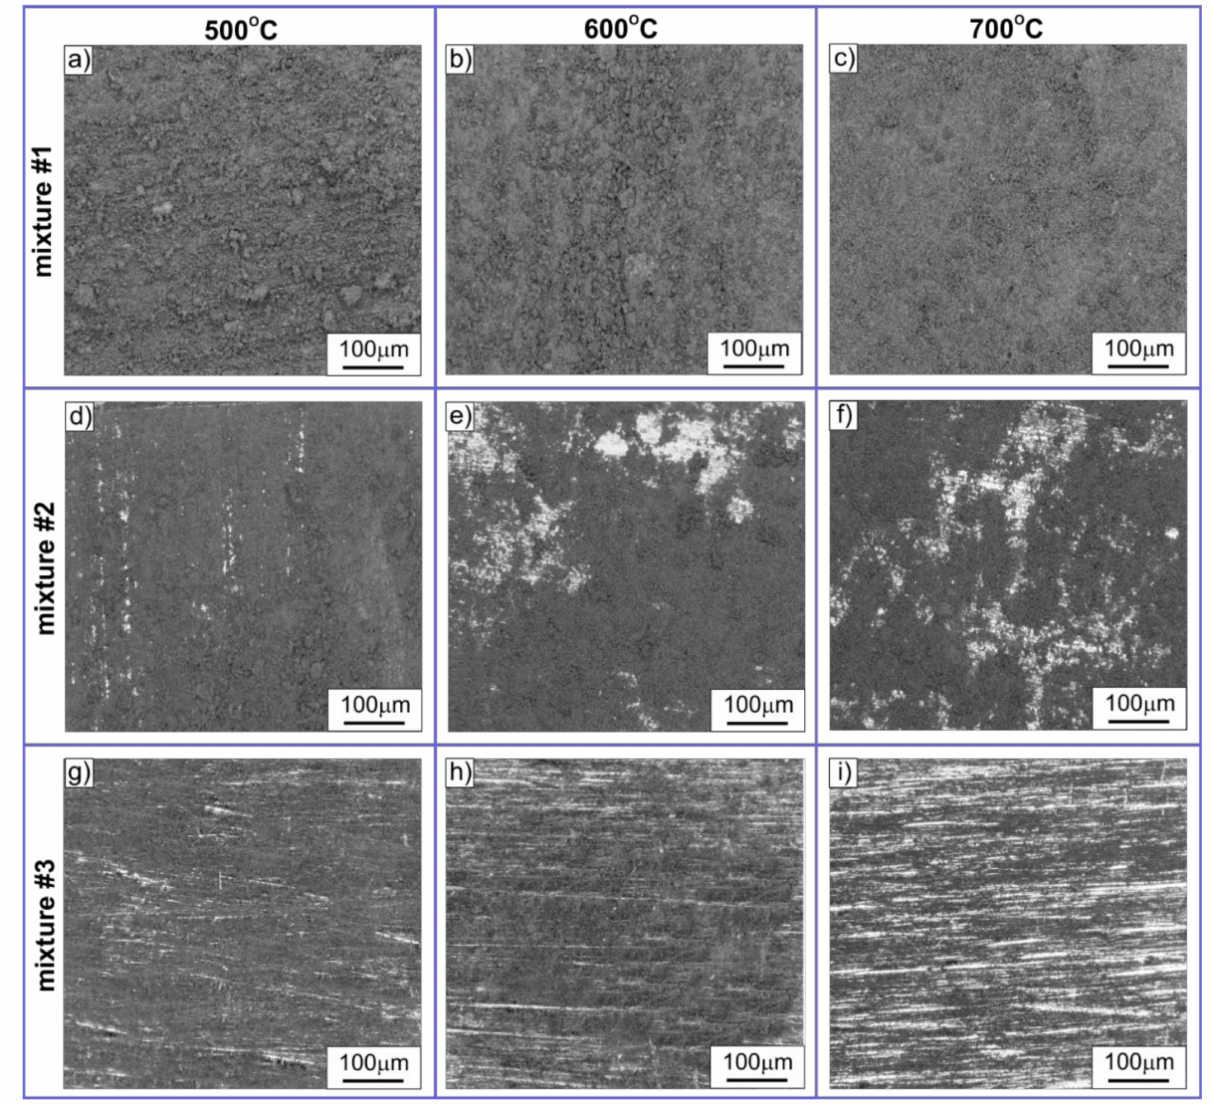
Figure 1. LM morphology of Ni 3 Al foils surface layer after decomposition of: ( a – c ) mixture #1, ( d – f ) mixture #2, ( g – i ) mixture #3 at temperature: ( a , d , g ) 500 ◦ C, ( b , e , h ) 600 ◦ C, and ( c , f , i ) 700 ◦